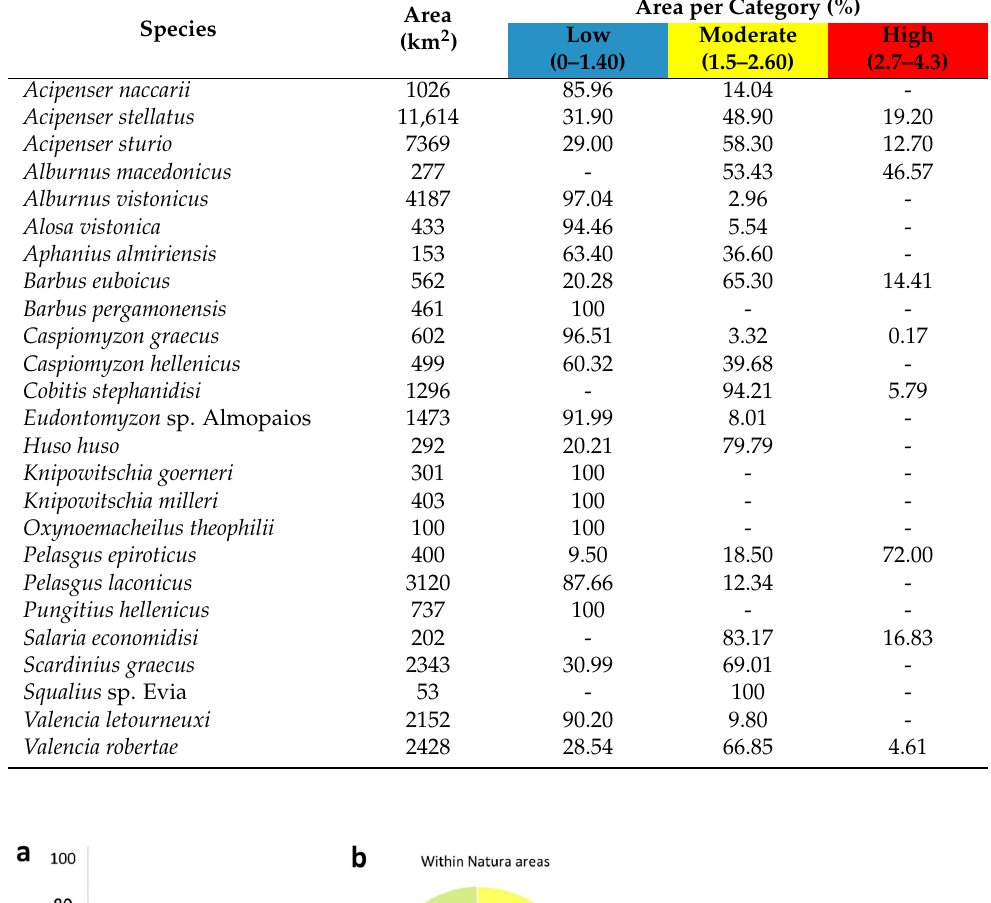
Table 4. The distributional coverage and the overlapping areas per critically endangered freshwater fish species for each NIFS predicted richness category (low, moderate, high).